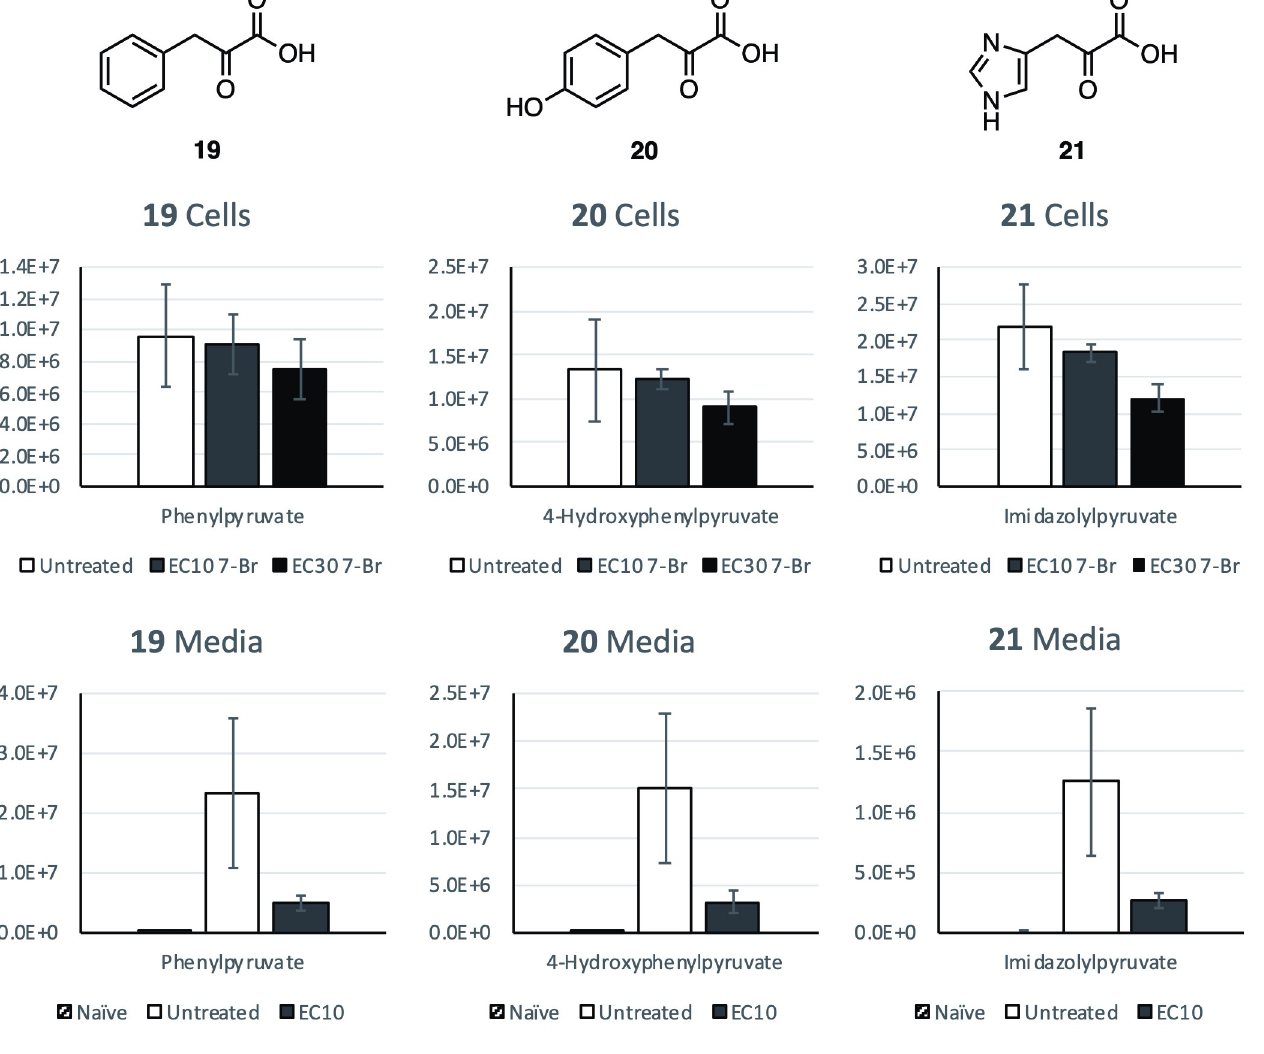
Fig 5. The effect of 7-Br tryptophan methyl ester (13) treatment on the relative medium and cellular levels of selected metabolites phenylpyruvate (19), 4-hydroxyphenylpyruvate (20), and imidazolylpyruvate (21). Relative levels are detected ion counts by MS from separate samples. Error bars show SD calculated from n = 3